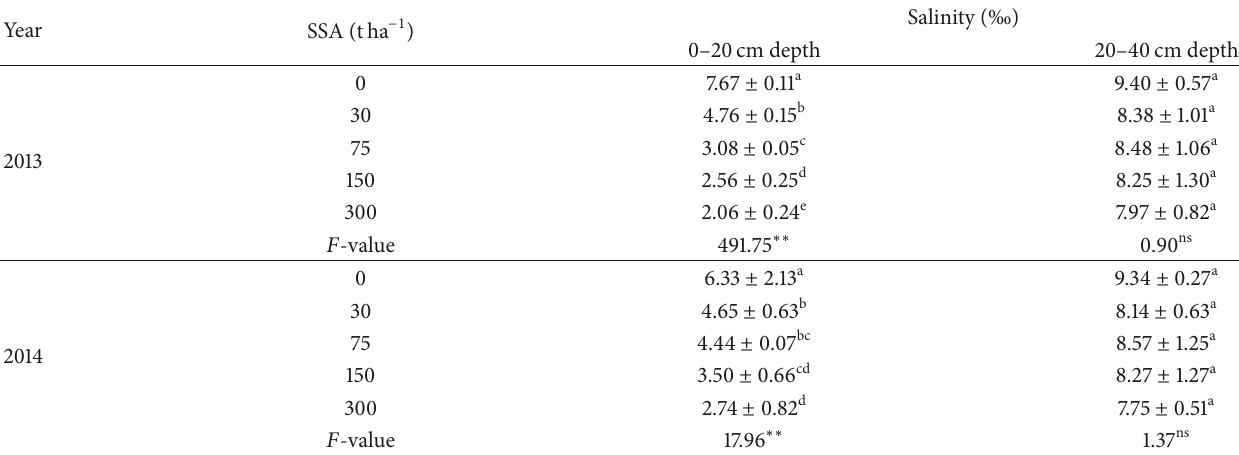
Values are mean ± SD of three replicates. Different letters in each column indicate significant difference at 𝑝 < 0.05 by LSD’s multiple range test. Values of 𝐹 are the 𝐹 test in ANOVA; ∗ 𝑝 < 0.05 ; ∗∗ 𝑝 < 0.01 ; ns 𝑝 > 0.05